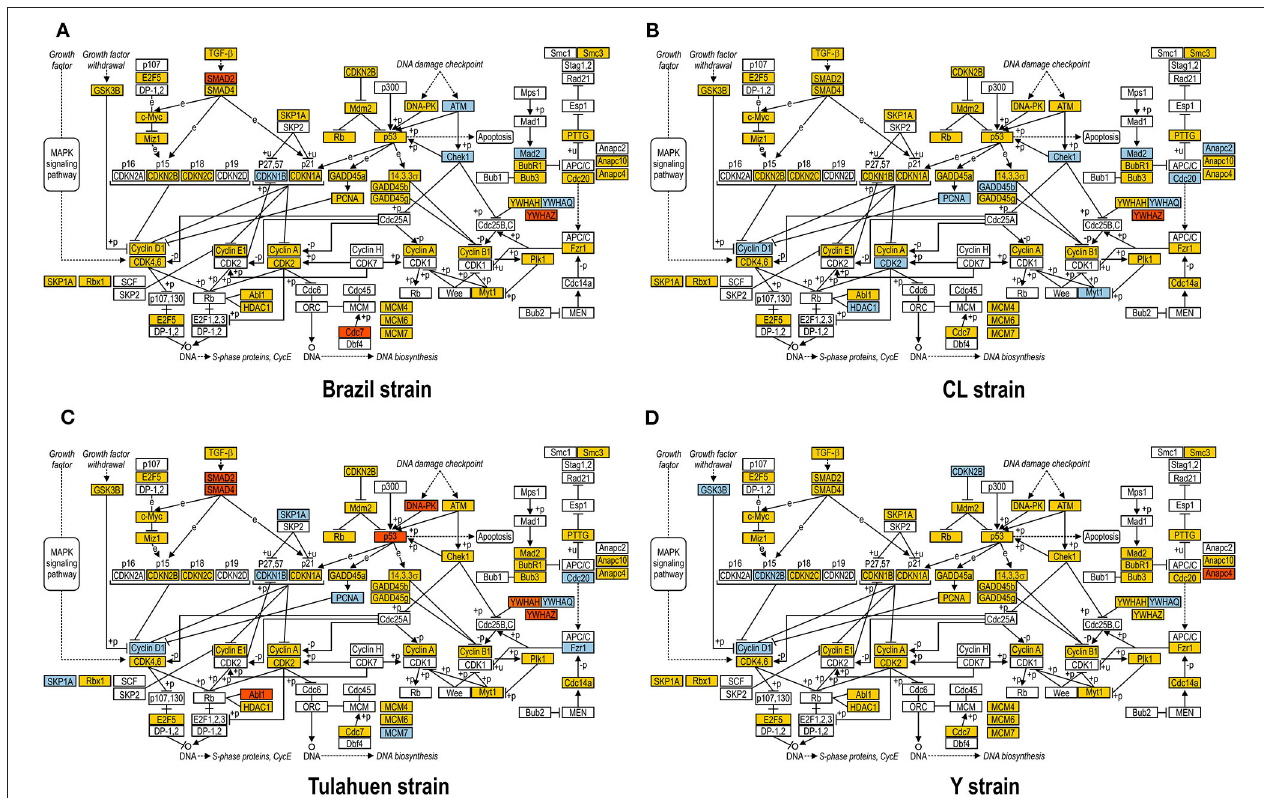
FIGURE 3 | Kyoto Encyclopedia of Genes and Genomes (KEGG) analysis of the Cell Cycle Pathway in Trypanosoma cruzi -infected myoblasts. The Cell Cycle Pathway obtained from the KEGG platform was used as template to highlight the effect of Brazil (A) , CL (B) , Tulahuen (C) , and Y (D) strain in L6E9 rat myoblasts. Blue boxes indicate genes that were significantly upregulated ( > 1.5-fold), and red boxes indicate those that were significantly downregulated ( < -1.5-fold). Yellow boxes indicate genes that showed no significant alteration in infected vs. control cultures, and white boxes indicate genes that were absent in the analysis (i.e., those that for any reason did not match the exclusion criteria; e.g., a positive signal in all four biological replicas of each group). Distinct stimuli can regulate the expression of cyclins and cyclin-dependent kinases (CDKs) and transcription factors (E2F5, and E2F1, 2, and 3) that coordinate cell cycle progression, DNA biosynthesis, and S-phase protein